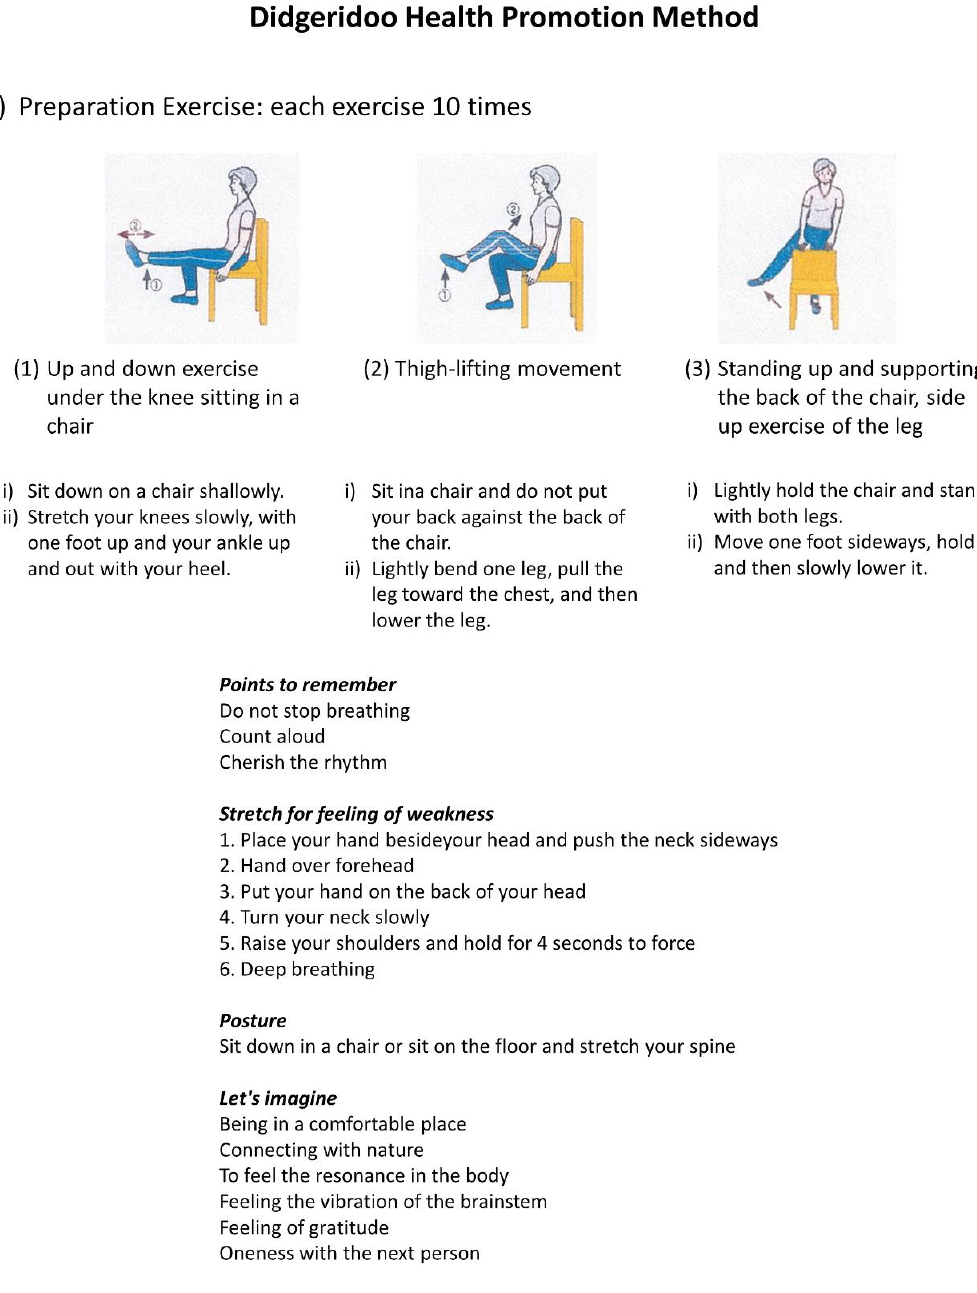
Figure 2. Preparation activity of the DHPM. An overview of the preparation activities of the DHPM. This is a 10-min preparatory movement, and while feeling the sense of oneness with nature and vibration of the brainstem, furthermore, feel the sense of oneness with the next person, loosen the whole body, relax the mind, and try to immerse yourself in the actual